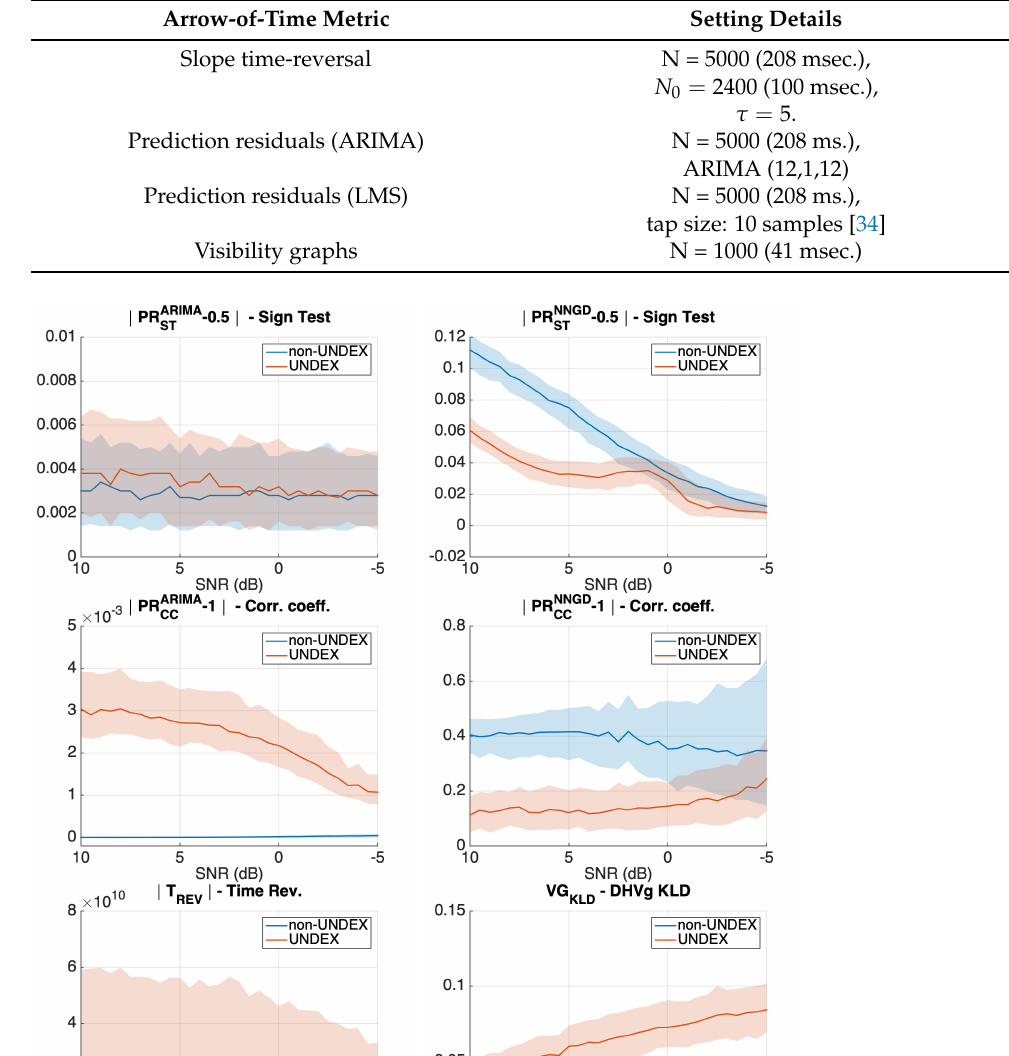
Table 1. Setting details used for the different arrow-of-time metrics.